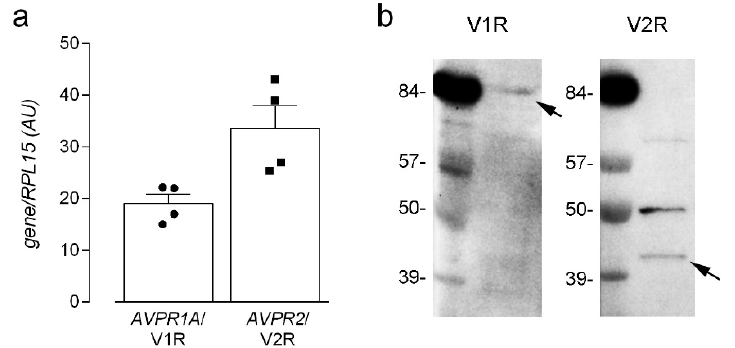
Figure 2. Expression of vasopressin receptors in microvascular endothelial cells. The expression of mRNA ( a ) and protein ( b ) for AVPR1A /V1R and AVPR2 /V2R receptors was assessed in HLMVEC by means of RT-qPCR with the ∆∆ Ct method and normalized for that of the housekeeping gene RPL15 (see Material and Methods). and Western Blot analysis, respectively, as described in Methods. Data in ( a ) are means ± SEM of four determinations, each performed in duplicate, while a representative blot is shown in ( b ) that, repeated three times, gave comparable results.